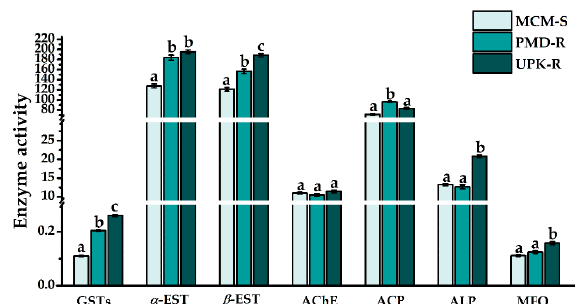
Figure 1. Enzyme activity in 4th instar larvae of the pyrethroid-susceptible (MCM-S) and resistant (PMD-R and UPK-R) Ae. aegypti prior to treatment (untreated group, 0 h time point). Each bar represents Mean ± SE of six or ten biological samples from different preparations. Bars with different letters on top indicate statistically significant differences among mosquito strains (Tukey’s HSD test, p < 0.05). Table 1. Enzyme activity in pyrethroid-susceptible (MCM-S) and resistant (PMD-R and UPK-R) strains of Ae. aegypti after treatment with LC 50 of P. crispum oil.